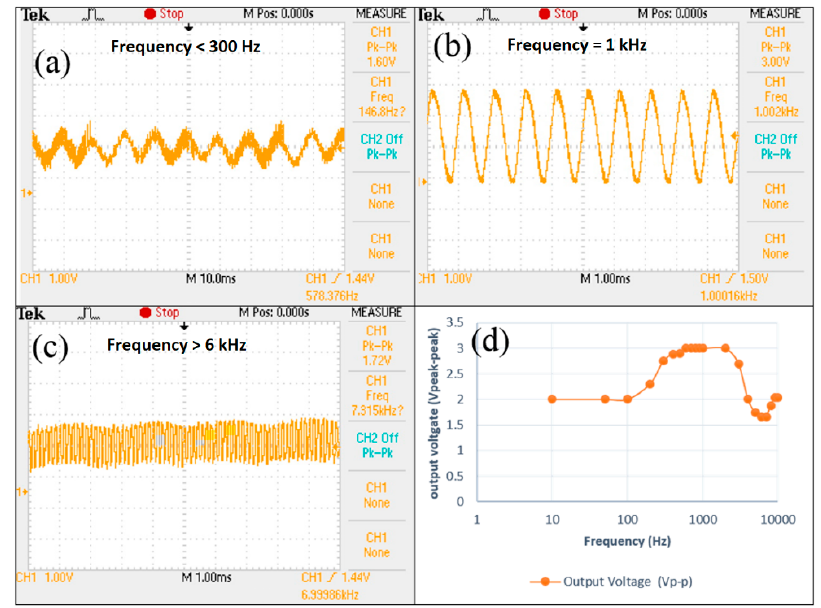
Figure 14. Output of APD, ( a ) for input sine signal below 300 Hz, ( b ) for input sine signal of 1 kHz, and ( c ) for input sine signal greater than 6 kHz. ( d ) Plot of APD output at varying frequency range and constant amplitude.